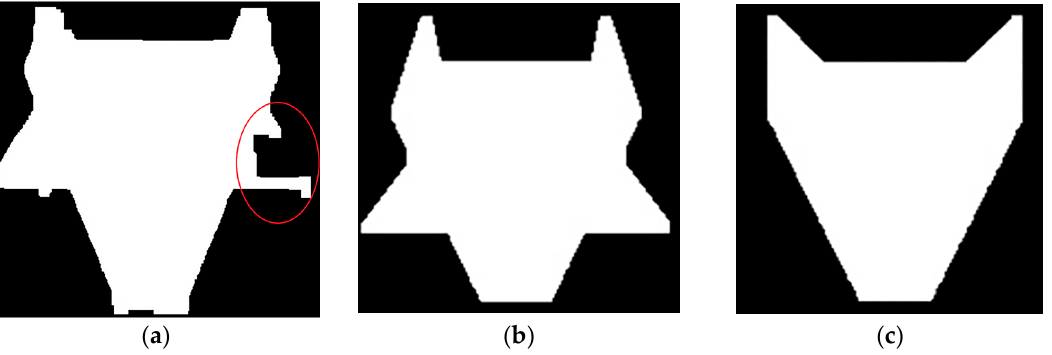
Figure 12. Filled mages of Pylon 3, Models 2 and 4: ( a ) the image of Pylon 3’s head points; ( b ) the image of Model 2; and ( c ) the image of Model 4.